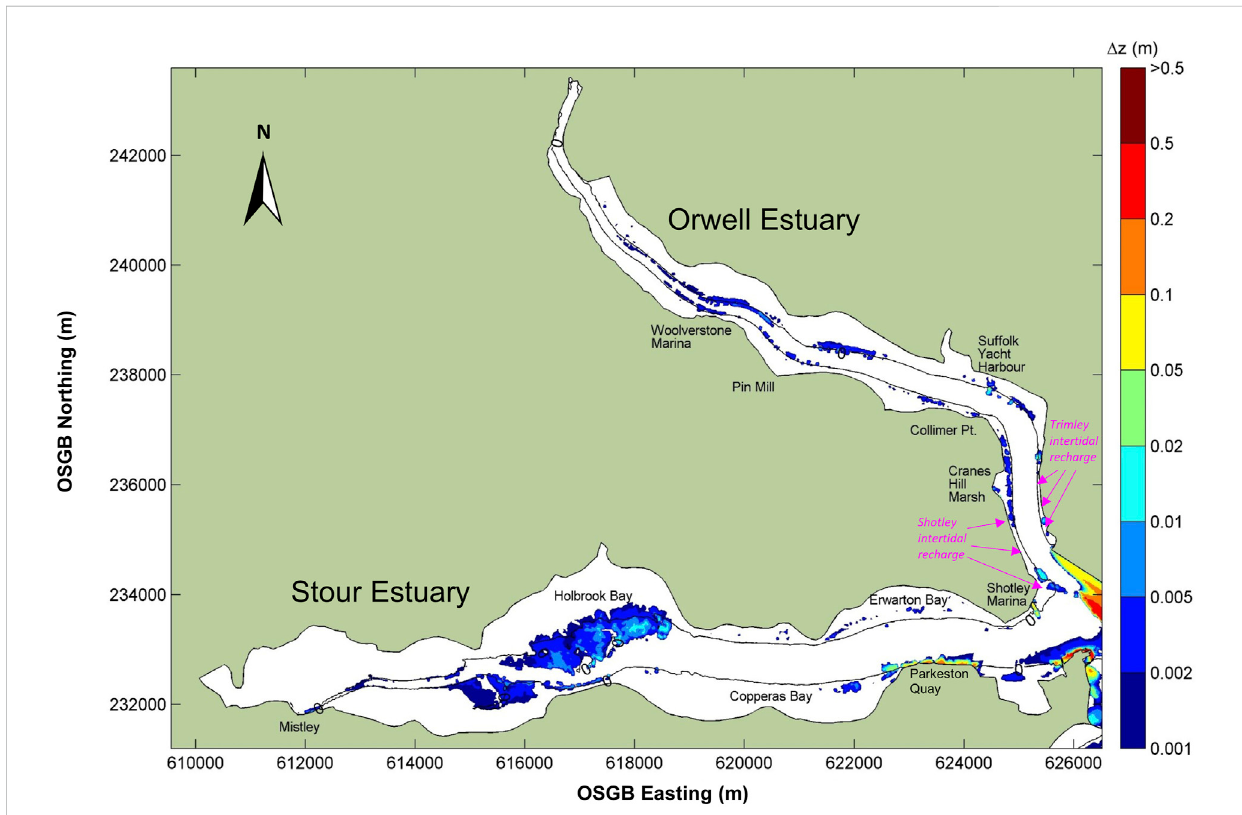
FIGURE 12 Predicted changes to the annual evolution of the estuary system due to the effect of sediment recycling (the iso-contour shown is the 0 mCD